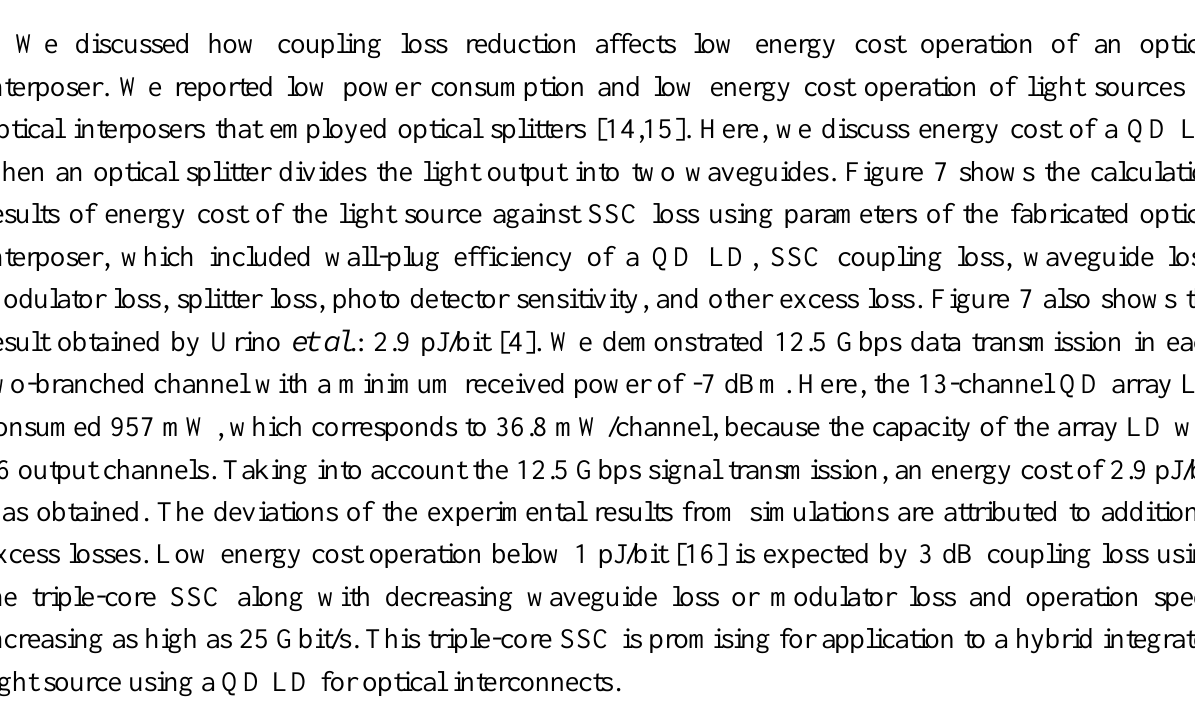
Figure 6. Coupling characteristics of a triple-core SSC for 1.3 μm wavelength and a QD LD. Minimum coupling loss was about 3.0 dB at zero